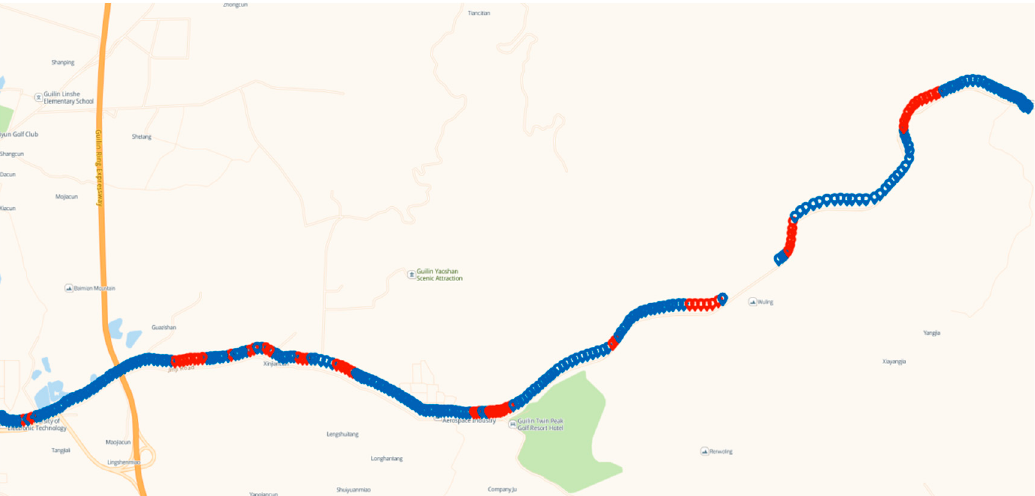
10 of 14 Figure 7. Prediction results of the combined test: ( a ) north position error and ( b ) east position error. Table 4. Comparing errors of the combined test in east-north direction. Driving state Position Error Value